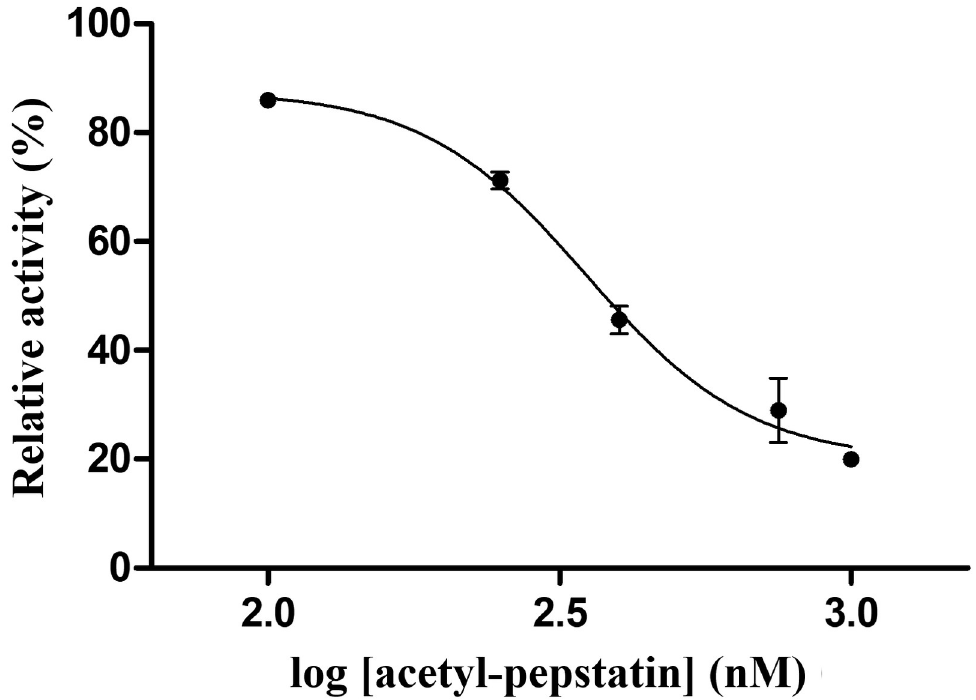
Fig 6. Inhibition of Ty1 PR-His 6 by acetyl-pepstatin. Inhibitory constant was determined using VPTIN � NVHTS synthetic oligopeptide substrate. Activity measured in the absence of inhibitor was defined as 100%. Error bars represent SD (n =